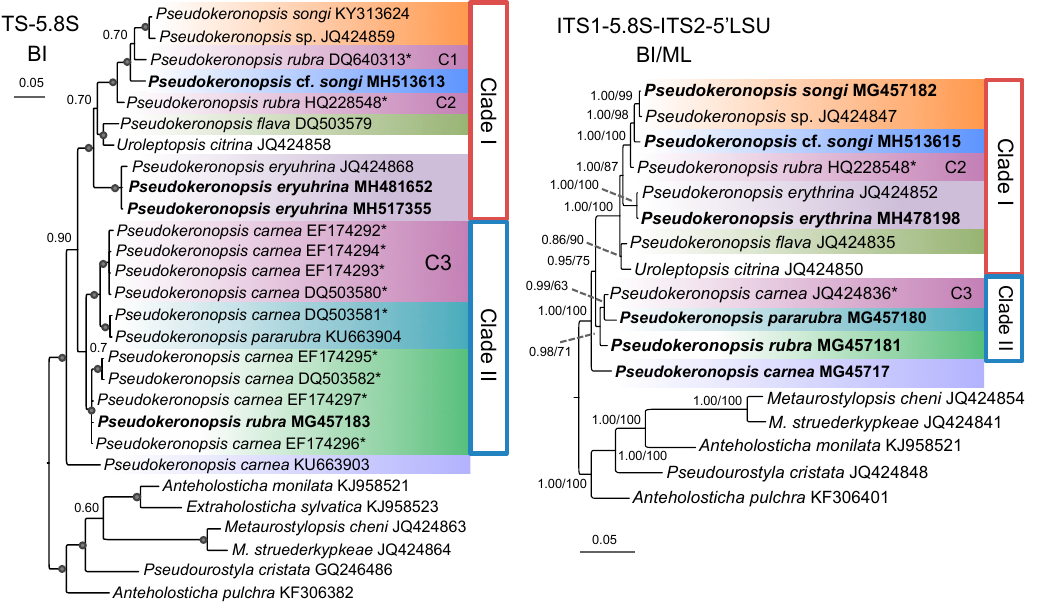
Figure7. Bayesianinference(BI)treesconstructedbyITS1-5.8S-ITS2(ITS-5.8S)andITS1-5.8S-ITS2-5 (cid:48) LSU Figure 7. Bayesian inference (BI) trees constructed by ITS1-5.8S-ITS2 (ITS-5.8S) and sequences showing phylogenetic relationships among the available pseudokeronopsids. The maximum ITS1-5.8S-ITS2-5 ′ LSU sequences showing phylogenetic relationships among the available likelihood (ML) tree and the BI tree of ITS1-5.8S-ITS2-5 (cid:48) LSU are identical in topology, and numbers at the pseudokeronopsids. The maximum likelihood (ML) tree and the BI tree of ITS1-5.8S-ITS2-5 ′ LSU are nodesrepresentBIandMLsupportvalues. Newlysequencedspeciesareinbold. *, misidentifiedspecies. identical in topology, and numbers at the nodes represent BI and ML support values. Newly sequenced species are in bold. *, misidentified species.